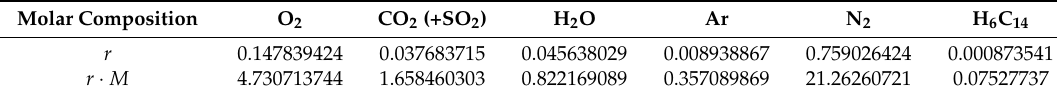
Table 8. The exhaust gas composition at 100% SMCR, ISO